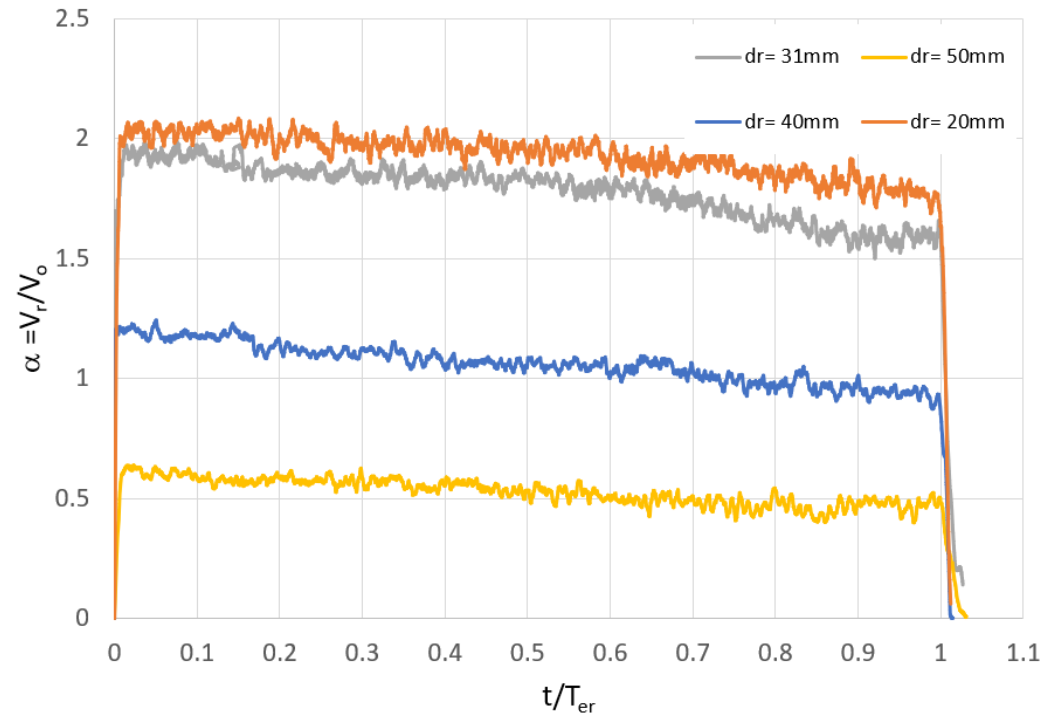
Figure 15. Temporal variation of the tip rotor’s speed ratio (4-blade rotors).